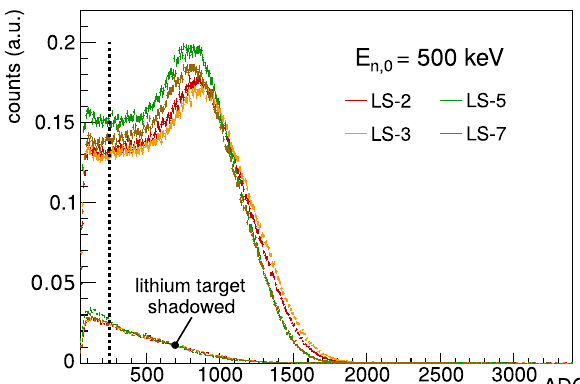
Fig. 7 Energy distribution obtained for four representative LS detec- tors exposed to a 500keV neutron beam during commissioning. The bottom distributions are obtained by shadowing the LiF target with a polyethylene cone and allow to estimate the background contribution from air scattering. The threshold at 250ADC used for the analysis (black dashed line) was chosen such to minimize the discrepancies in terms of neutron efficiency between the detectors